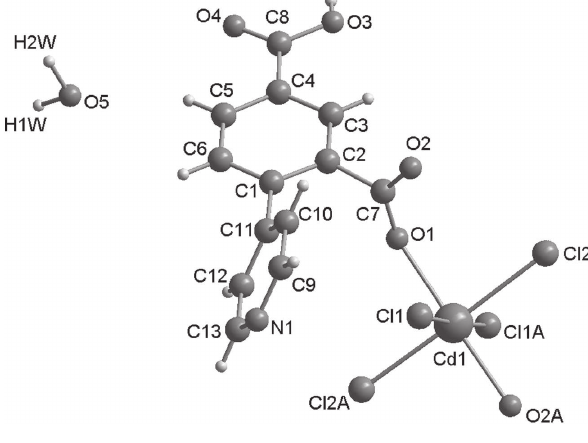
Table 1: Data collection and